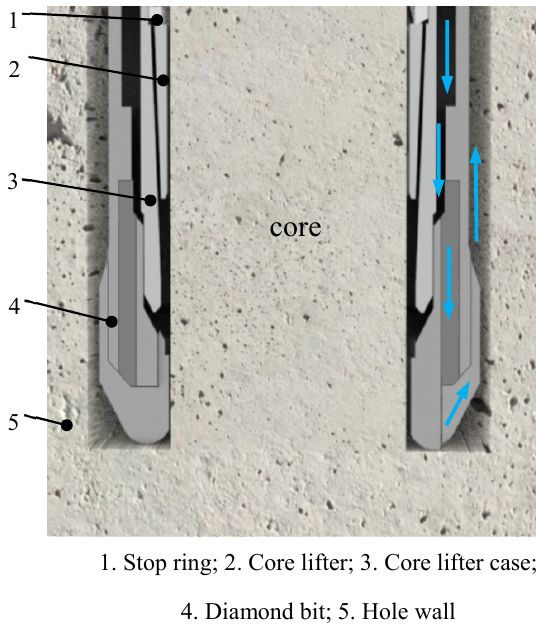
Figure 3. Water passage model diagram.